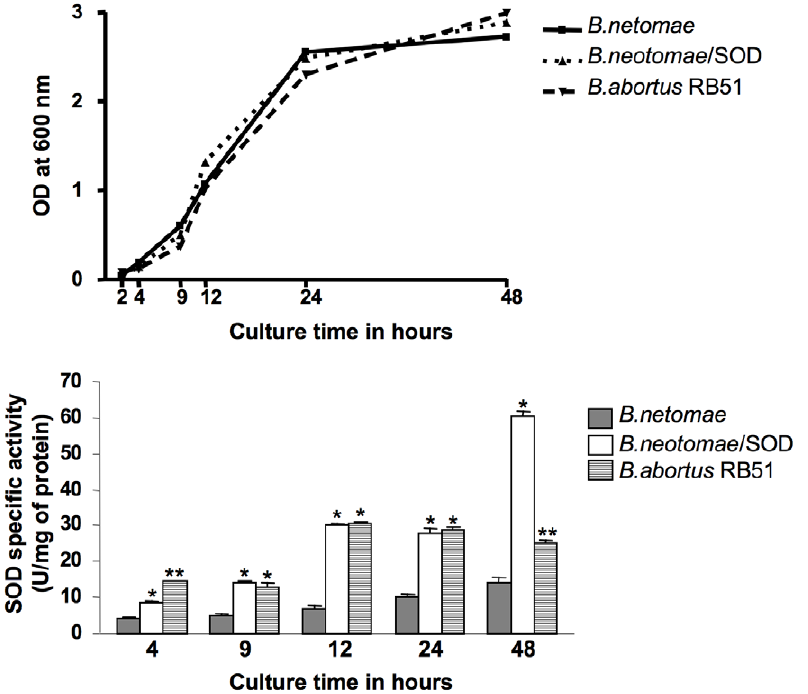
Figure 2. Specific activity of SOD enzyme in the periplasmic extracts of B.neotomae , B.neotomae /pBB4SOD, and B.abortus RB51 at different growth stages. The growth curves of the bacteria are shown in the top panel. The specific activities of SOD enzyme are shown in the bottom panel. For each Brucella , overnight culture was used at 1:200 dilution to inoculate fresh 100 ml media and at different time intervals, the OD 600 was measured and an aliquot of the culture was taken for preparing periplasmic extracts. With extracts of each time-point, the SOD assay was performed twice, each time in duplicates, and the results are shown as the mean 6 standard deviation of specific activity (units/mg of protein). At each time point, the groups with one or two asterisks were significantly different from the B. neotomae group ( P , 0.001). At 4 and 48 hours time- points, there were significant differences between the groups with different number of asterisks ( P , 0.001).